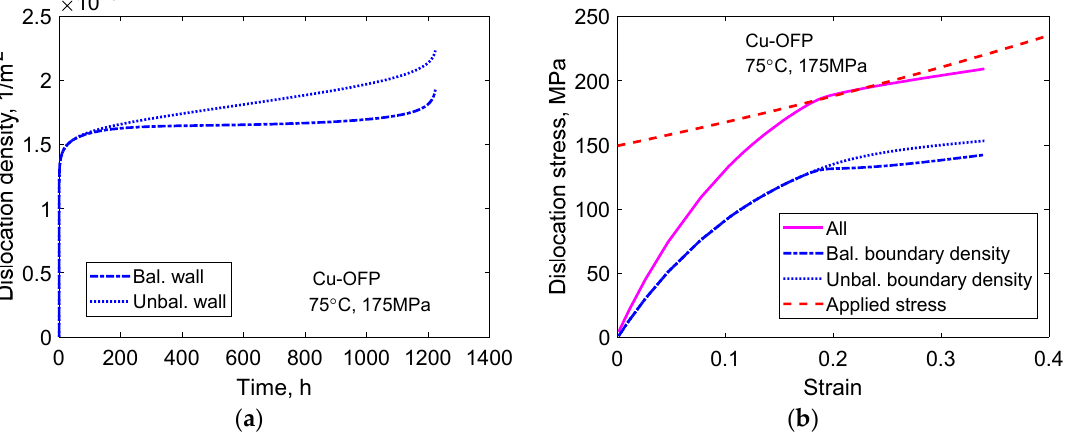
Figure 14. Model results for the same case as in Figure 13 (Cu-OFP at 75 °C and 175 MPa). ( a ) Dislocation densities versus time, Equations (23) and (24); ( b ) Dislocation stresses versus strain, Equation (3). Redrawn with permission from ref. [17]. Copyright 2022 Elsevier.